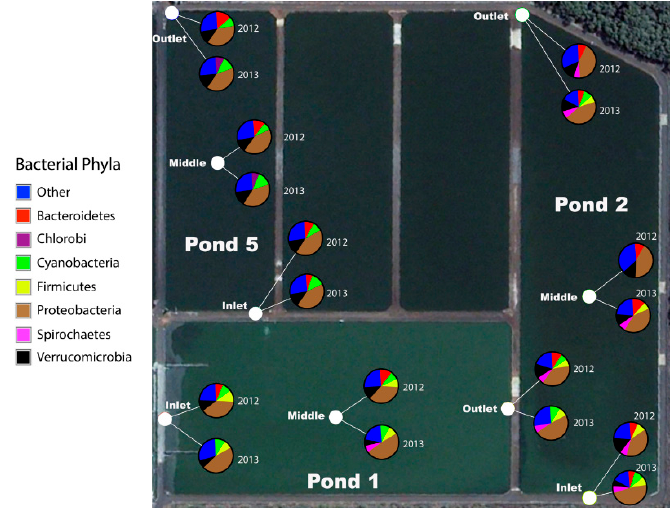
Figure 3. Distance-based redundancy analysis (dbRDA) based on a distance linear model of Sanderson bacterial communities and the physico-chemical environment. Dry = dry season, Wet = wet season, P1 = Pond 1, P2 = Pond 2 and P5 = Pond 5.